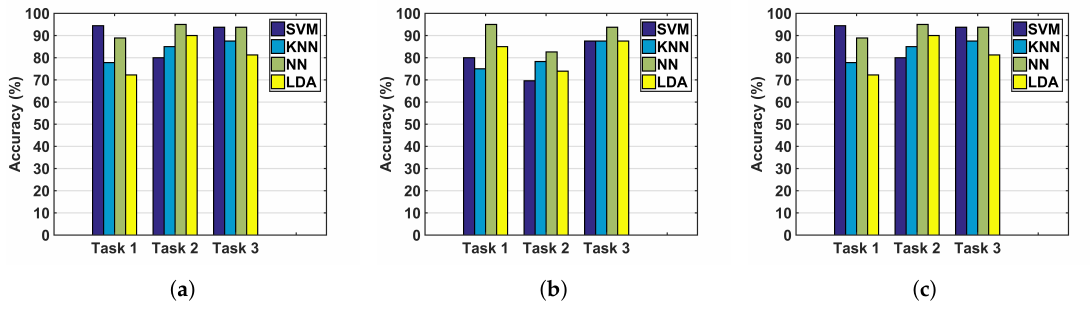
Figure 5. Accuracy using ( a ) only the instrument’s metrics; ( b ) using only the arthroscope’s metrics; and ( c ) using metrics of both the instrument and the arthroscope. SVM: support vector machine; KNN: K-nearest neighbors; NN: neural network; LDA: linear discriminant analysis.